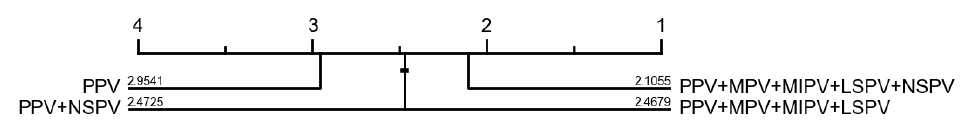
Figure 10. Mean rank of CEEMD-MultiRocket using different combinations of pooling